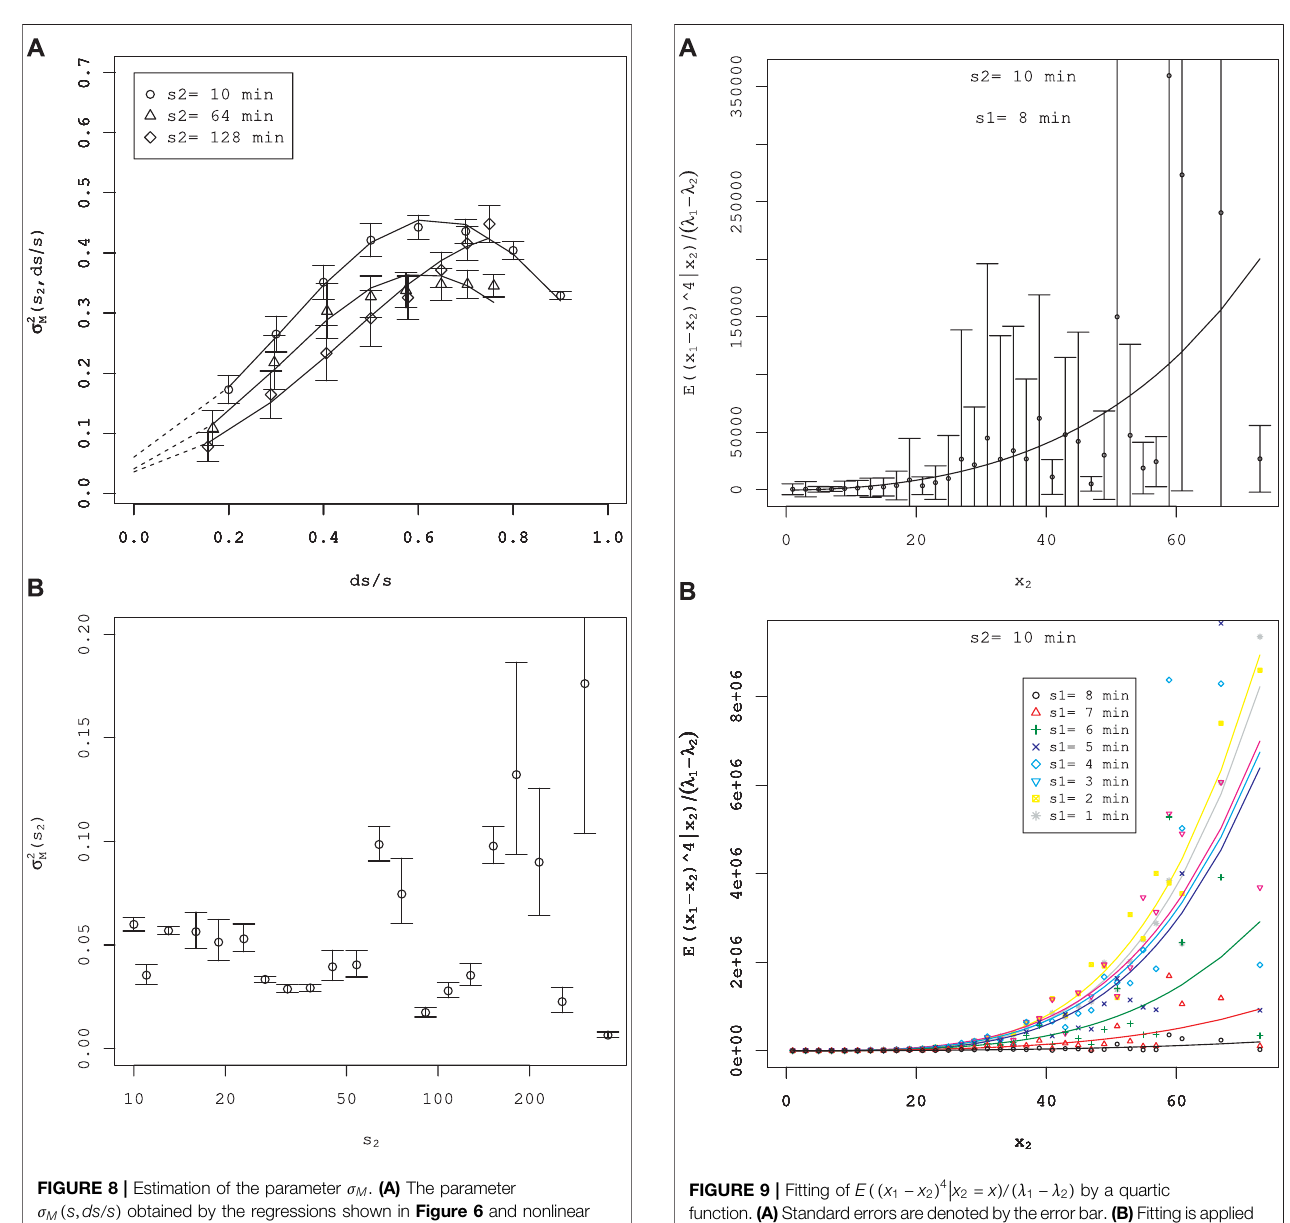
FIGURE 8 | Estimation of the parameter σ M . (A) The parameter σ ( s , ds / s ) obtained by the regressions shown in Figure 6 and nonlinear M fi tting log ( σ 2 ( s )) (cid:2) a + b ( ds / s ) + c ( ds /s ) 2 . The standard errors of regression M ( Eq. 31 against x 2 are denoted by an error bar. (B) σ 2 M ( s ) (cid:2) exp ( a ) (see the text). Standard errors of nonlinear fi ttings are denoted by an error bar.